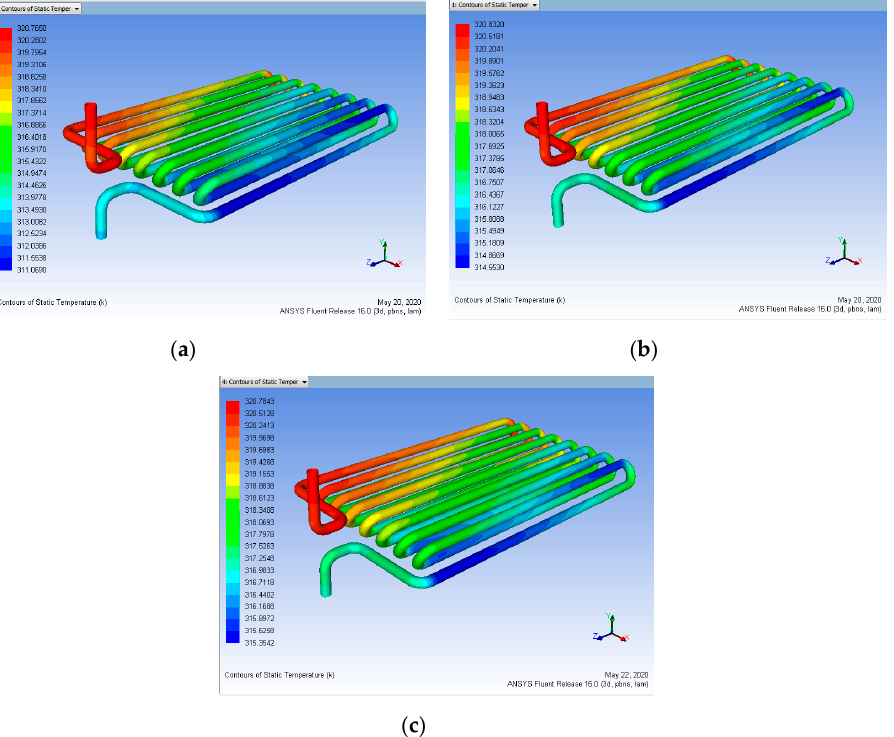
Figure 14. Heat input 323 K vs. Coating Thickness 100 µ m for mass flow rate ( a ) 0.15, ( b ) 0.30, ( c ) 0.45 L / min (After